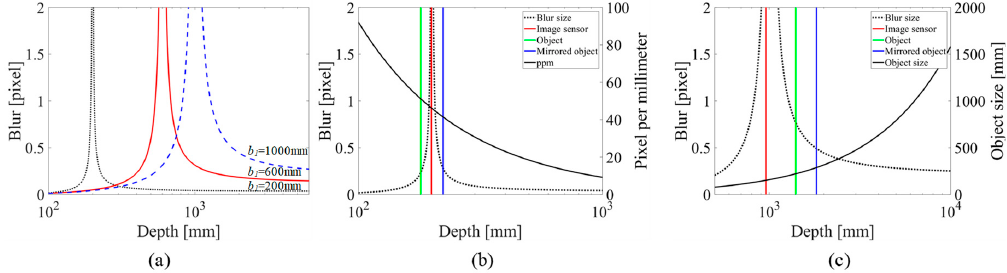
Figure 6. ( a ) Blur radius of microlens versus depth of scene according to various focus distances ( b 1 ) in log scale; ( b ) Focal plane between the object and the mirrored image: focus distance ( b 1 ) is 200 mm and object location is 180 mm. Solid black line represents spatial resolution of captured image in pixel per millimeter (ppm); and, ( c ) Focal plane in front of object: focus distance ( b 1 ) is 1000 mm and object location is 1400 mm. Solid black line represents maximum object size to be captured.